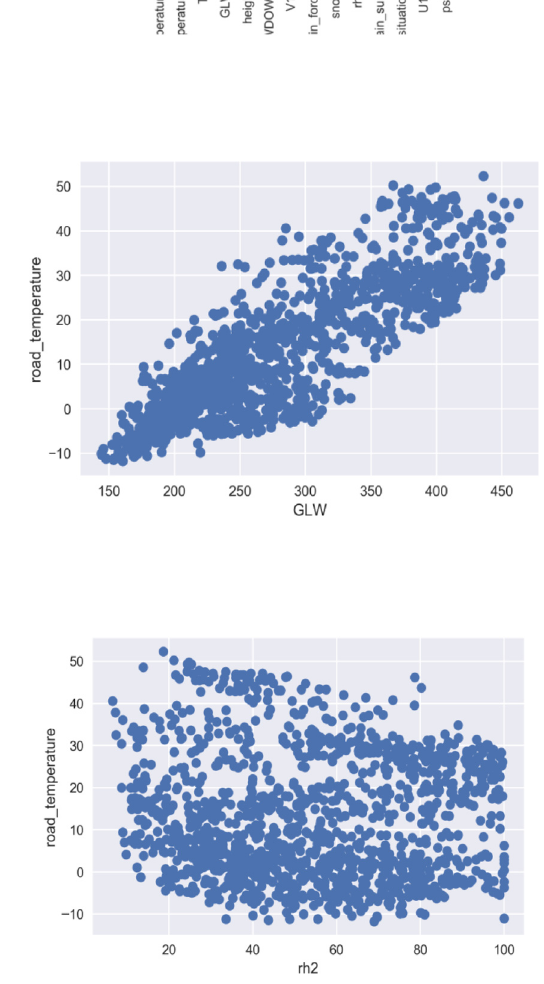
Figure 1. Pearson correlation coef fi cient between each variable